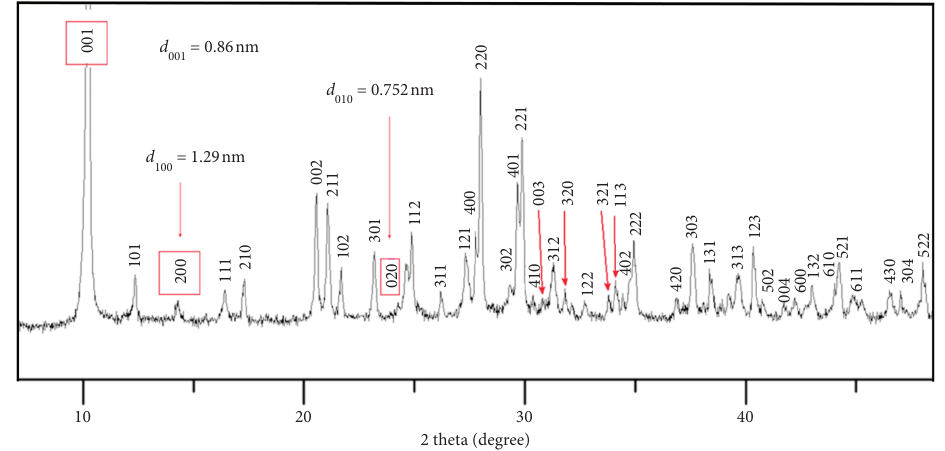
Figure 6: XRD diffraction patterns of LEuH-Cl [Eu